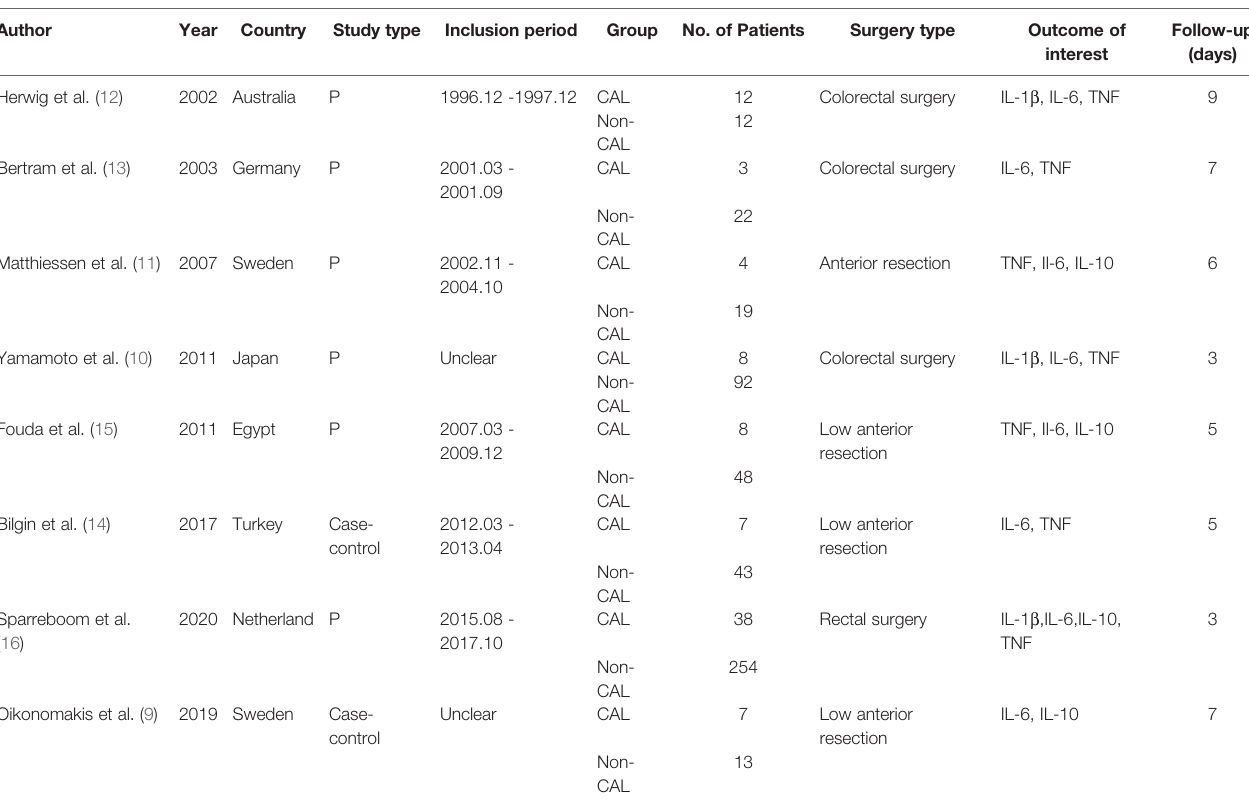
TABLE 4 | Characteristics of included